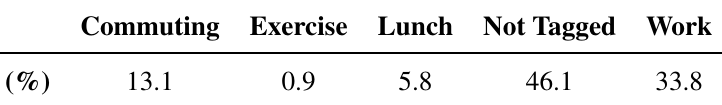
Table 6. Percent of states of each class (subject 2).